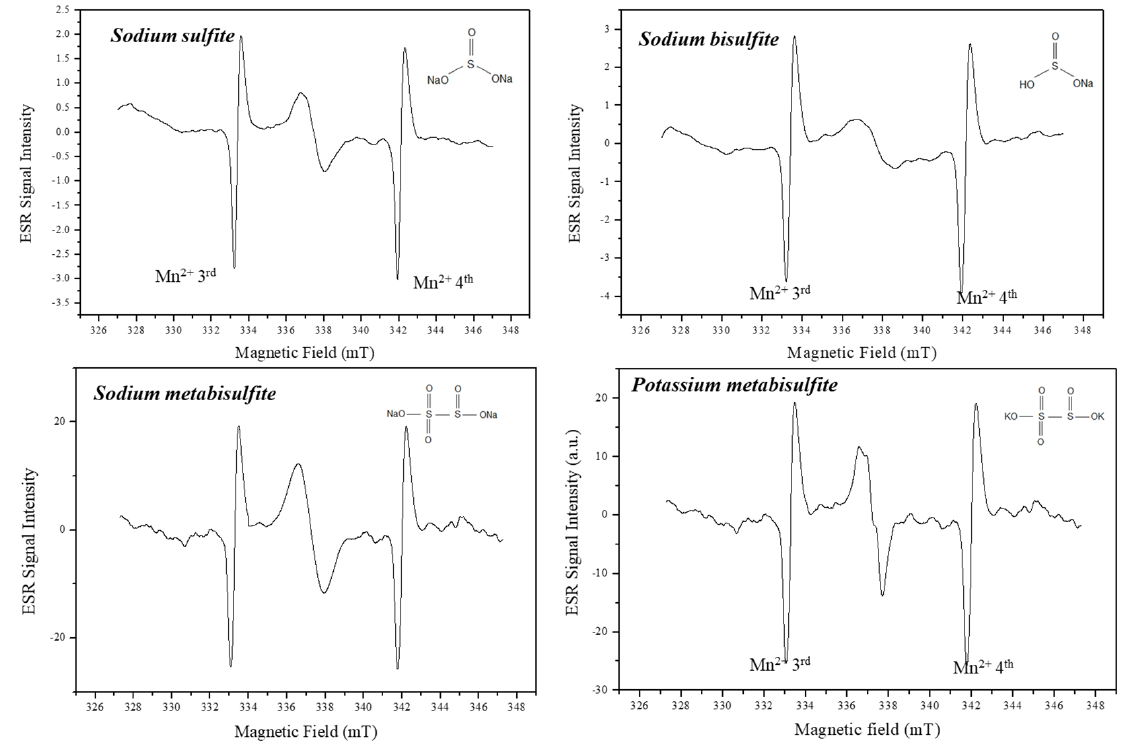
Figure 1. ESR signal of non-irradiated sulfites and their chemical structure. Spectra were recorded with Mn marker.